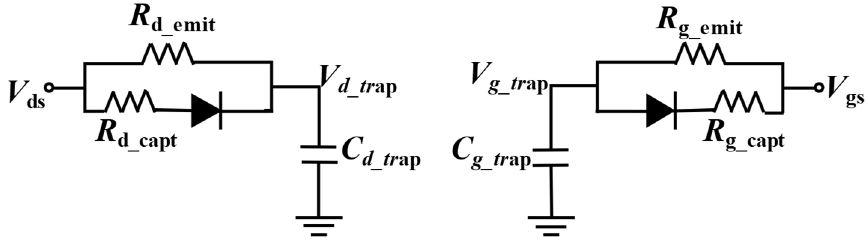
Figure 1. Equivalent circuit topology of the trap model of drain current proposed in this paper.